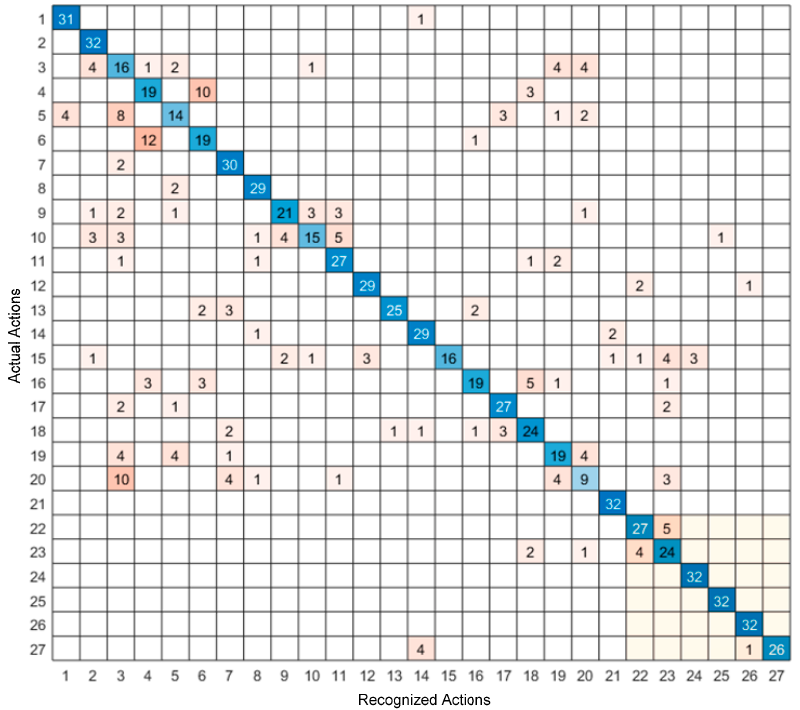
Figure 5. Recognition accuracy for the four situations of sensing modality across the eight subjects in UTD-MHAD dataset.